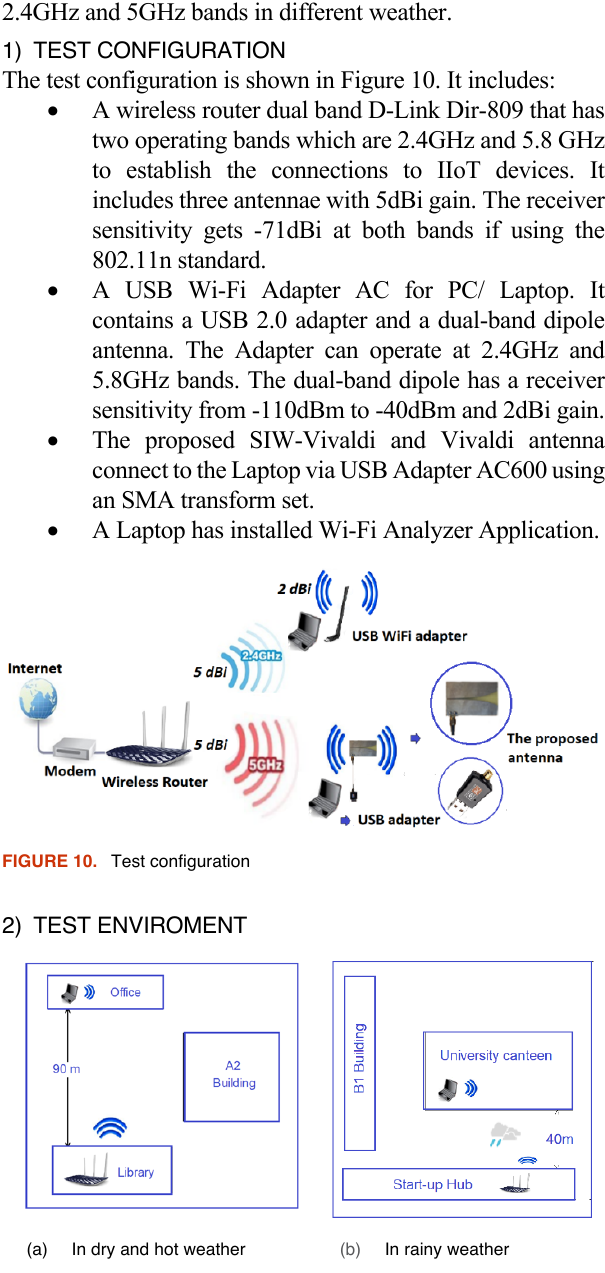
FIGURE 9. S11 Parameter of Vivaldi antenna with and without SIW structure.